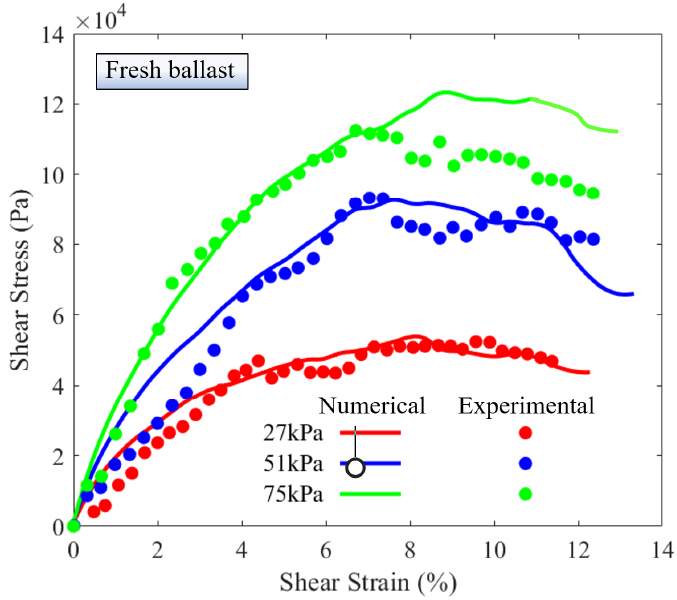
Figure 7. Shear behavior of fresh ballast under different confining pressures.